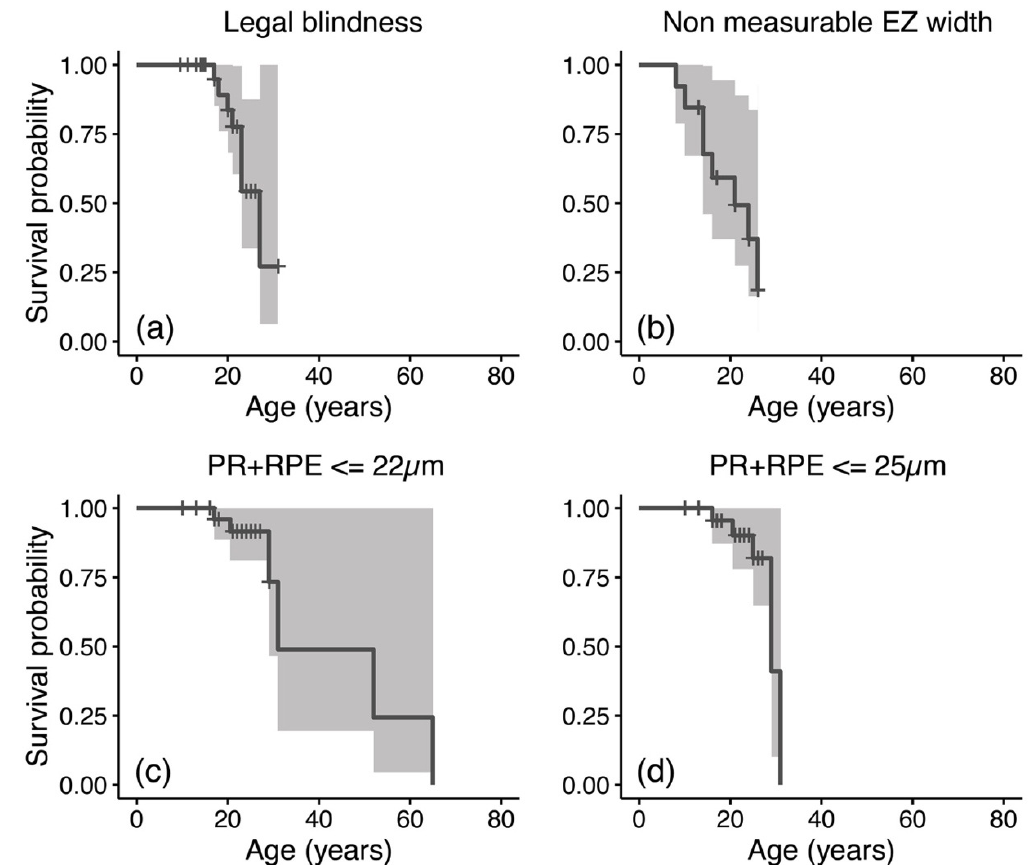
Figure 4. Kaplan–Meier curves for best corrected visual acuity (BCVA), ellipsoid zone (EZ) width, and photoreceptor and retinal pigment epithelium (PR+RPE) thickness. For BCVA analysis ( a ), an outcome of BCVA ≥ 1.00 LogMAR (legal blindness) was considered. For EZ width ( b ) the selected outcome was a finding of not measurable EZ. For PR+RPE thickness, a value of 22 µm was considered ( c ) and the analysis was repeated by considering the 95th percentile of PR+RPE in this sample for patients aged 30 years or more ( d ); 95% confidence intervals are also reported underneath survival curves.